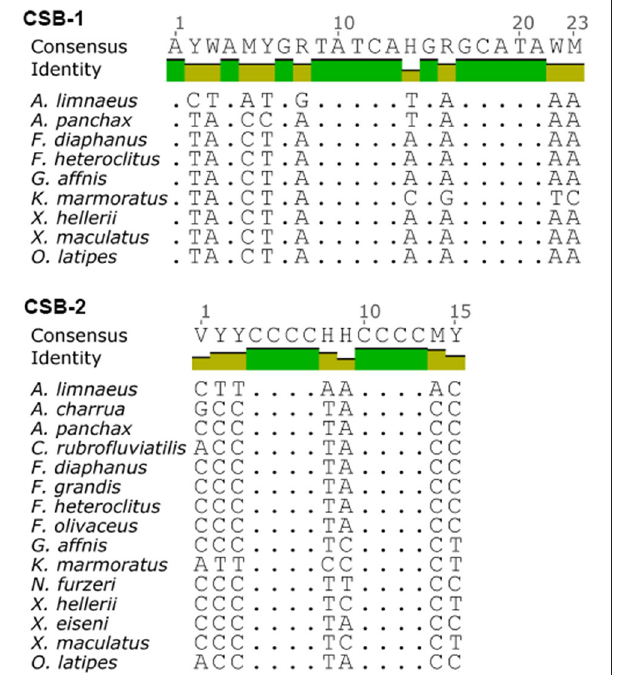
FIGURE 4 | Comparison of PSIPRED secondary structure results for A. limnaeus and bovine ND6. The secondary structure predictions of ND6 in the two species suggests that the A. limnaeus protein may be lacking a complete first helix when compared to bovine.